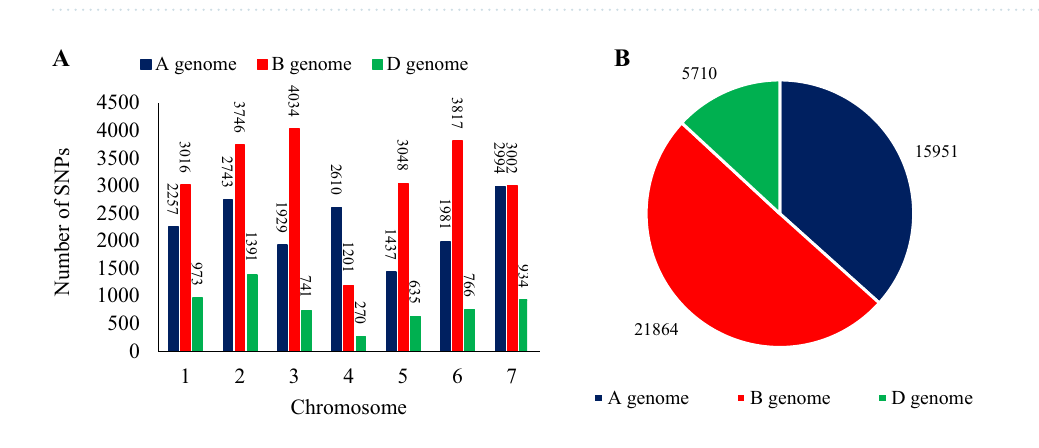
Figure 3. Number of imputed SNPs used in wheat chromosomes ( A ) and genomes ( B